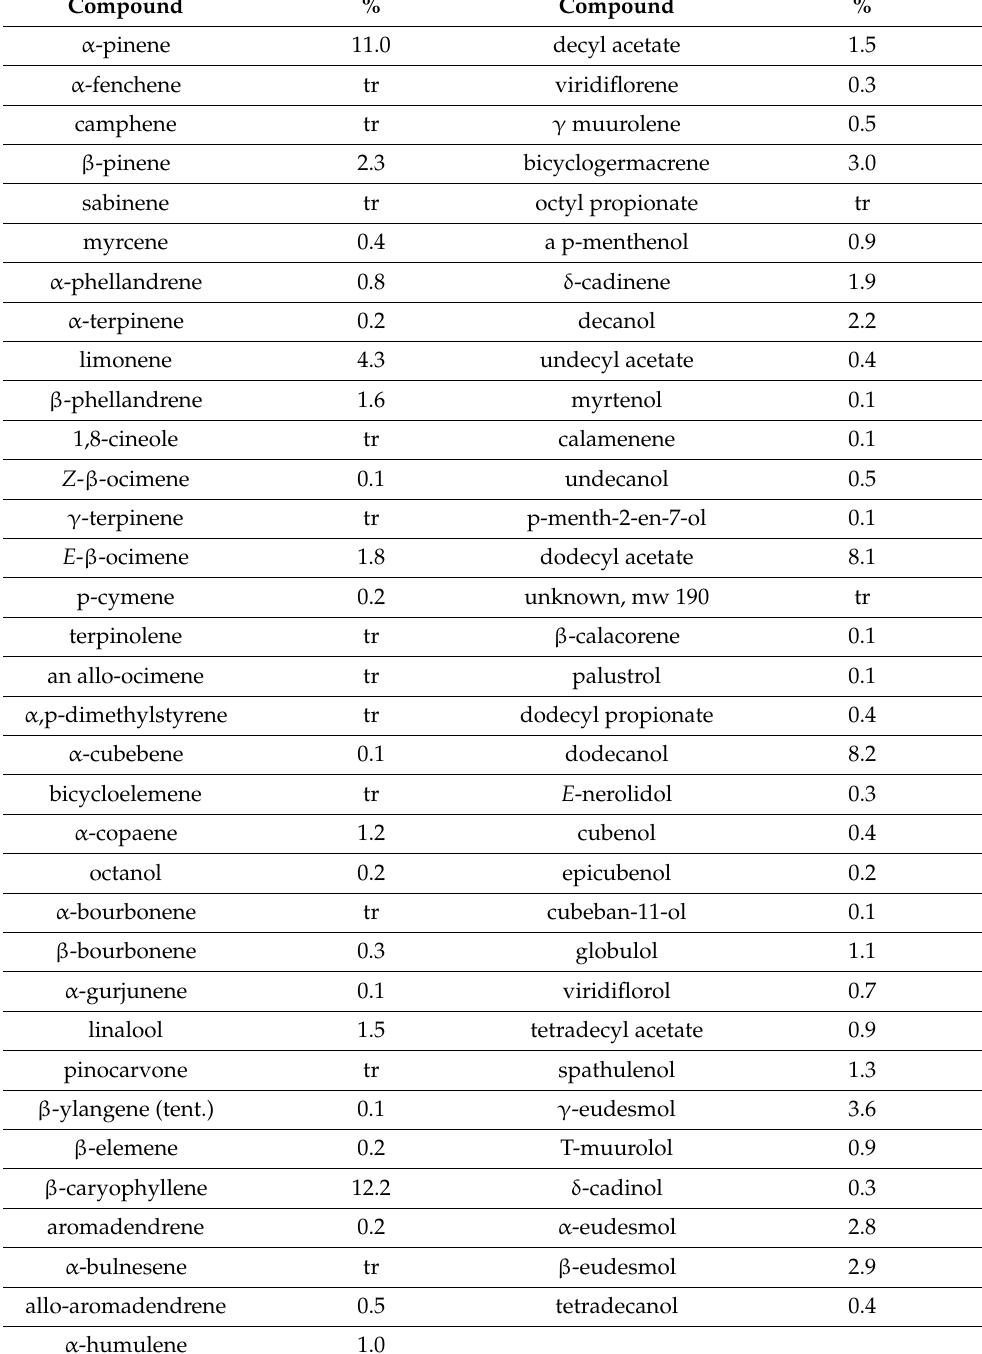
Table 11. Compounds identified in the leaf oil of Backhousia oligantha